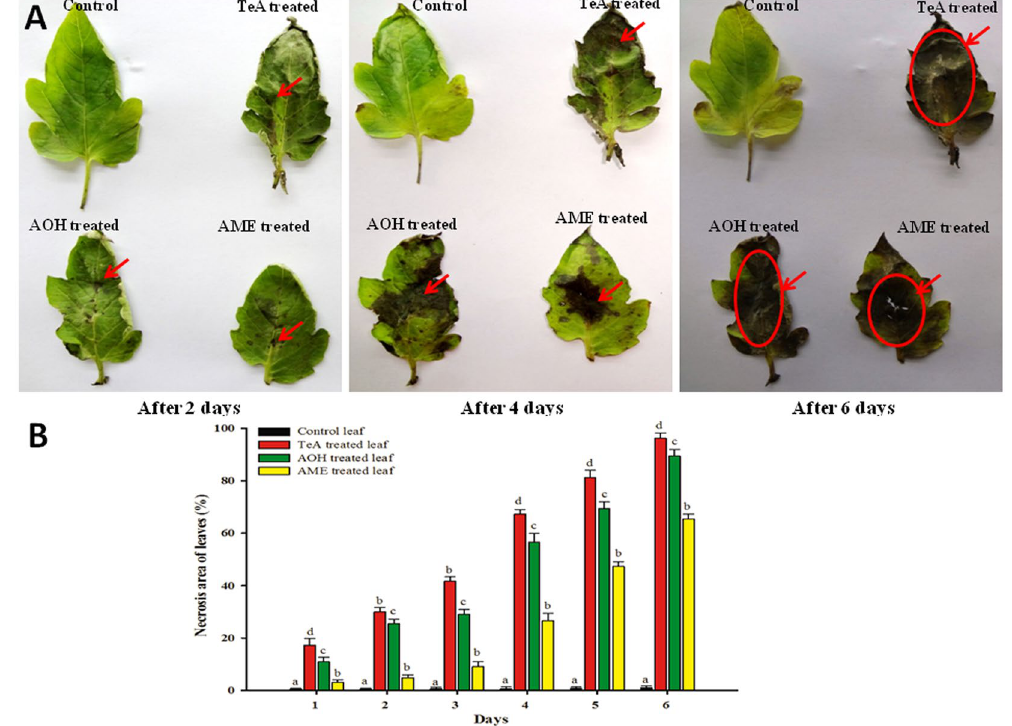
Figure 7. Comparision of toxic potency of TeA, AOH and AME on leaves of tomato plants. ( A ) Necrotic spots (diseased area) developed after 2, 4 and 6 days of mycotoxins inoculum treatment. ( B ) Graphical representation of percent diseased area (necrotic regions) and days after treatment of mycotoxins (results are expressed in mean of three replicates and vertical bars show the ± SD of the mean). Note: The arrows indicate the necrotic symptoms of diseased area.